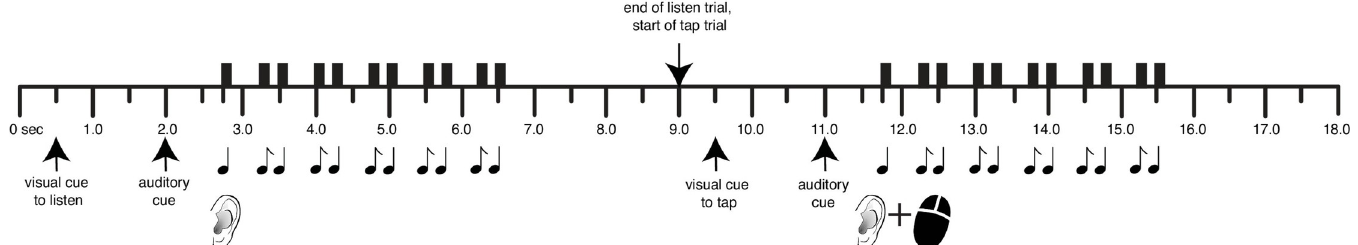
Fig 3. Examples of stimuli used in the c-RST. From top to bottom: low, medium, and high complexity rhythms. Low complexity rhythms (top) have the highest number of notes falling on the implied beat. Figure adapted from [19].